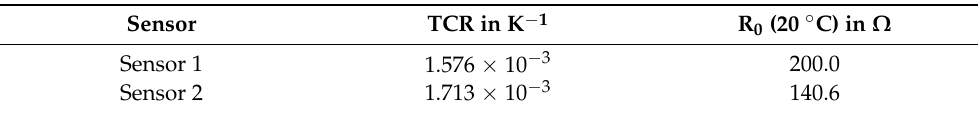
Table 1. Calculated temperature coefficients of resistance (TCR) of the sensors under test and the nominal resistances R 0 at a temperature of 20 ◦